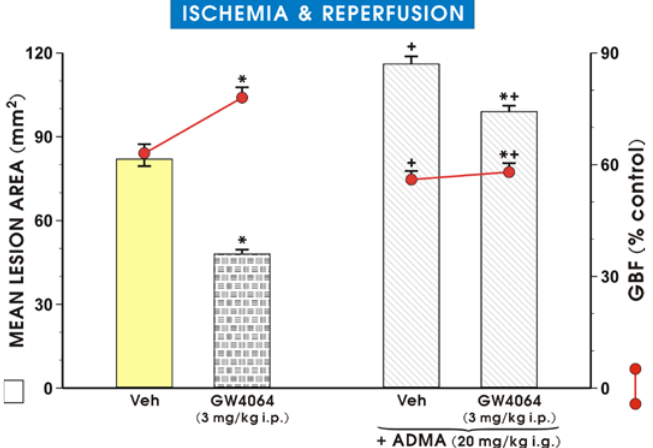
Figure 2. Mean lesion area and the changes in gastric blood flow (GBF) in vehicle and GW4064 (3 mg/kg i.p.) pretreated rats exposed to 3.5 h of ischemia/reperfusion in the absence and the presence of ADMA (20 mg/kg i.g.). Results are mean ± S.E.M of six rats per group. Significant change ( p < 0.05) as compared with the respective values in vehicle-control group is indicated by an asterisk. A cross indicates a significant difference ( p < 0.05) compared with the vehicle control treated group not treated with ADMA. A cross and an asterisk indicate a significant change ( p < 0.05) compared to the values obtained in rats treated with GW4064 without ADMA.